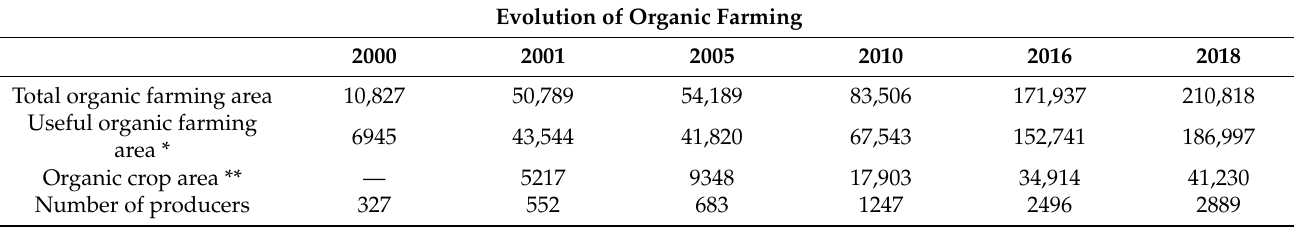
Table 5. Evolution of the organic farming area in Catalonia and number of producers. Source: DARP; Organic Food and Agriculture